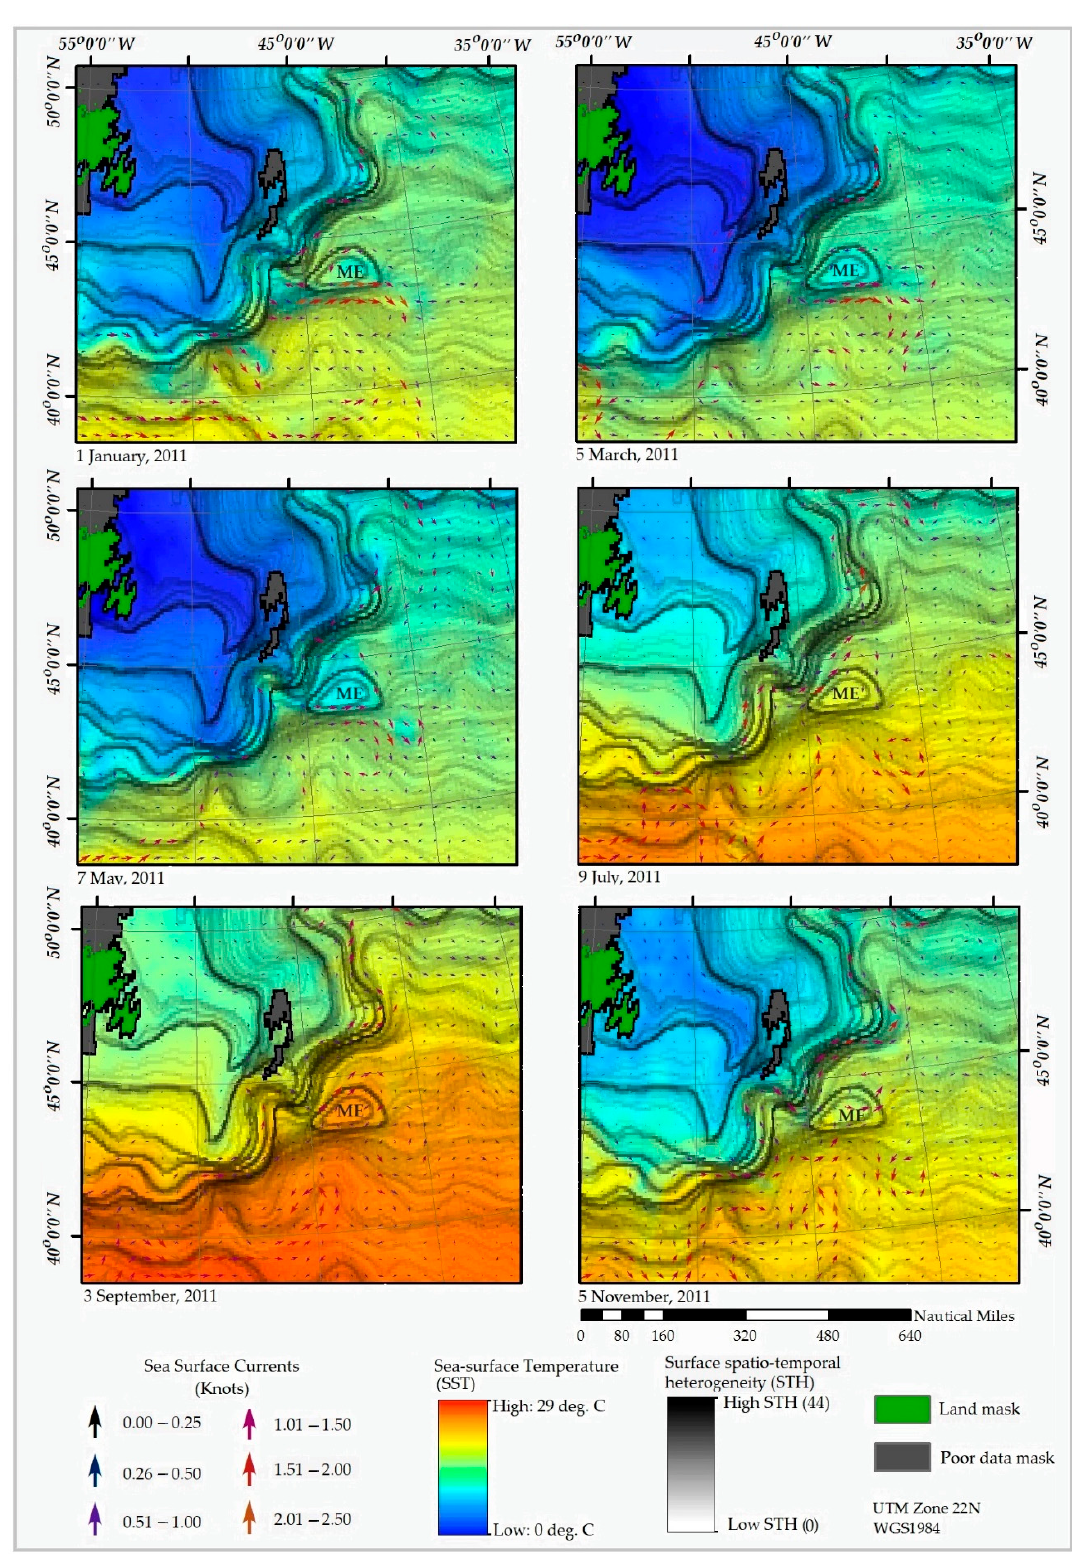
Figure 11. Six selected daily resolution SST and Surface Current (direction denoted by arrows, and speed by size and colour) images, taken throughout 2011, in the Newfoundland Basin Area (NBA). Images are overlaid with the 2011 STH dataset. The potential signature of the Mann Eddy (ME) is labelled ME throughout the sequence. Daily current direction and magnitude are derived from the GlobCurrent data product [46].